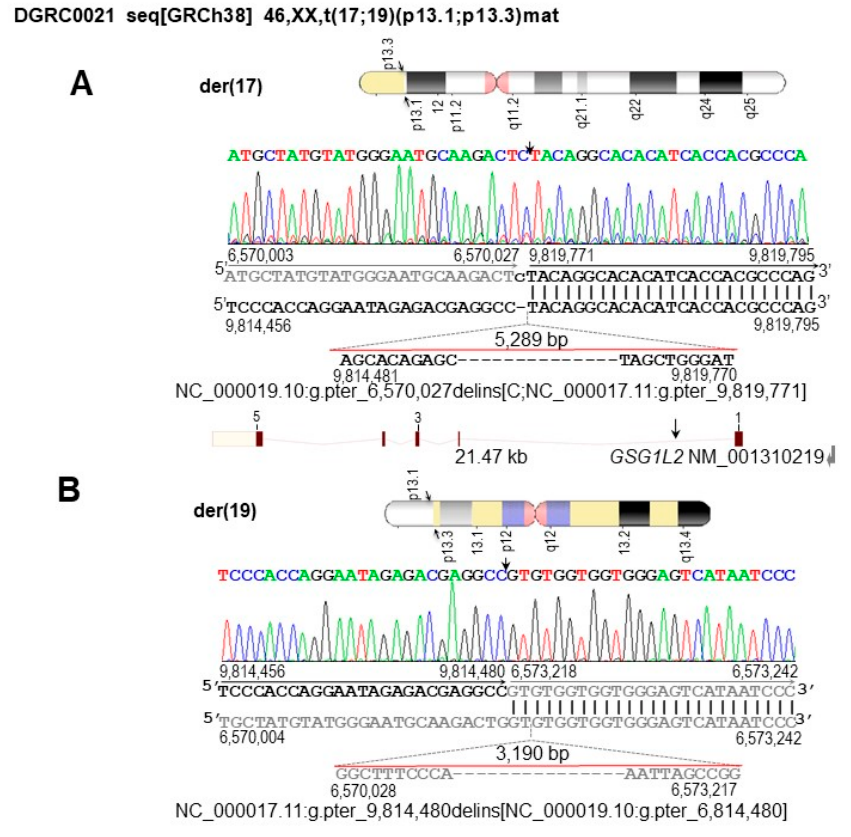
Figure 1. Characterization of the 46,XX,t(17;19)(p13.1;p13.3)mat breakpoint regions and affected genomic elements at nucleotide resolution. Arrows indicate breakpoint positions. The chromosome 17 sequence is in black whereas the chromosome 19 sequence is in gray. Vertical lines indicate identical nucleotides between derivative and reference chromosomes. Orientation of genomic sequences within the derivative chromosomes are indicated by color-coded arrows. ( A ) Ideogram of the der(17) chromosome and corresponding breakpoint region 17p13.1. The C nucleotide insertion is in lowercase. Below the sequence alignment, the 5289 bp deletion is depicted. The deletion is evi- denced by the difference between the genomic position of the 17p13.1 breakpoints on the derivative chromosomes (g.9,814,480_9,819,771del). Below, schematic map of GSG1L2 . Exons are depicted by numbers, whereas the position of the 17p13.1 breakpoint within IVS1 is indicated by an arrow. ( B ) Ideogram of the der(19) chromosome and corresponding breakpoint region at 19p13.3. Below the sequence alignment, the 3190 bp deletion is depicted. The deletion is evidenced by the difference between the genomic position of the 19p13.3 breakpoints on the derivative chromosomes (g.6,570,027_6,573,218del). Detailed ISCN- and HGVS-based descriptions of the der(17) and der(19) at nucleotide level are: NC_000019.10:g.pter_6,570,027delins[C;NC_000017.11:g.pter_9,819,771] and NC_000017.11:g.pter_9,814,480delins[NC_000019.10:g.pter_6,814,480]. The translocation is revised to seq[GRCh38] t(17;19)(19pter → 19p13.3::17p13.1 → 17qter;17pter → p13.1::19p13.3 → 19qter)mat.